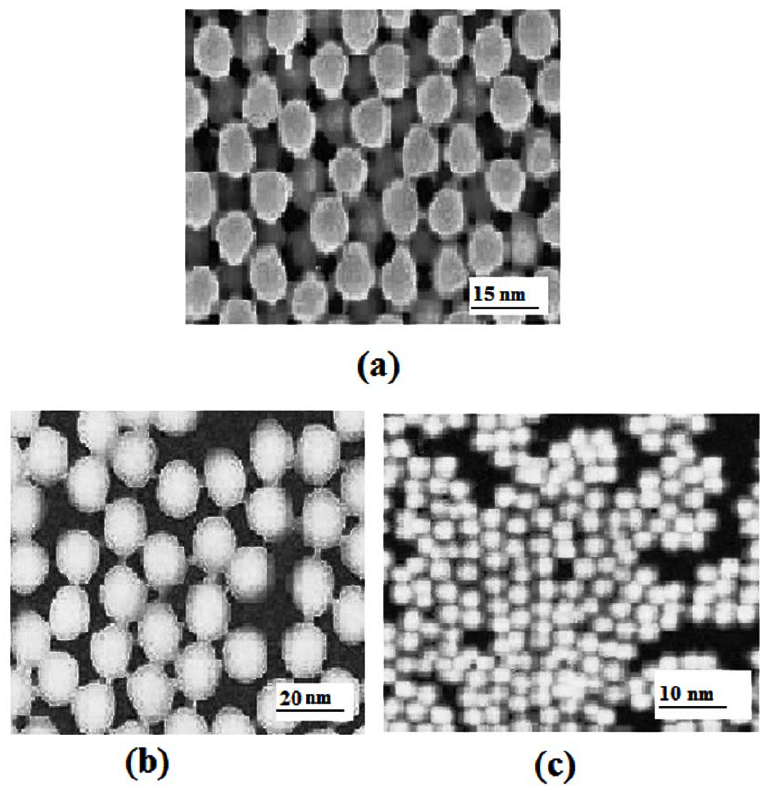
Figure 3. TEM micrographs of CMCh/PVA nanogels; ( a ) CMCh/PVA (2:1); ( b ) CMCh/PVA (1:1); ( c ) CMCh/PVA